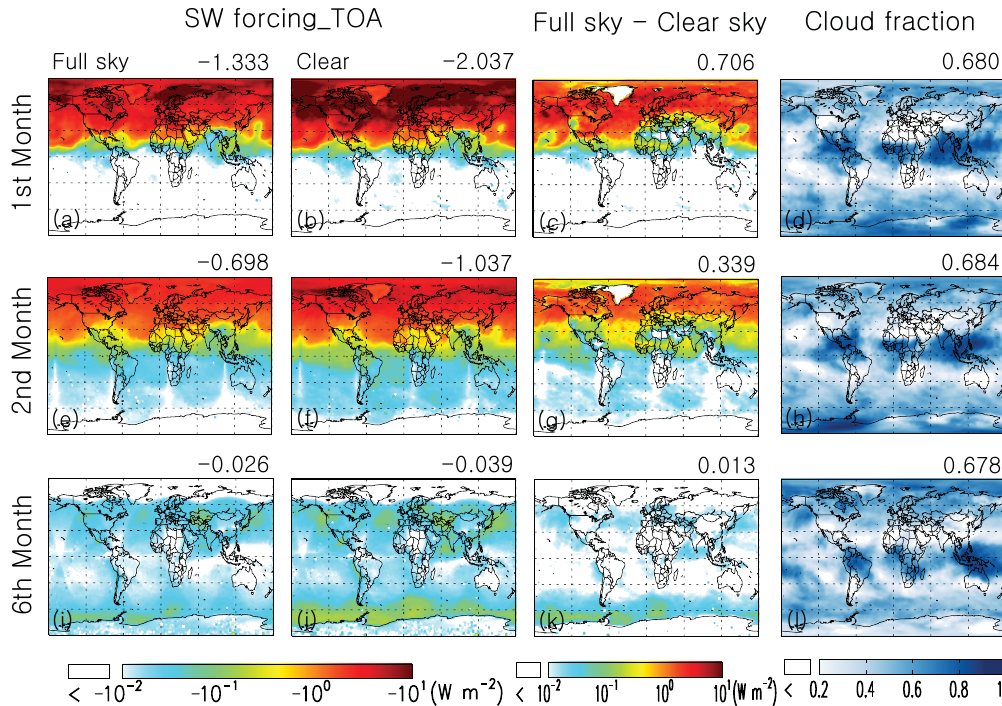
Fig. 8. Averages of volcanic sulfate shortwave (SW) radiative forcing (Wm − 2 ) at the top of the atmosphere (TOA) for all sky (a) and clear sky (b) conditions, as well as their differences (c) in the first month ( a–c ), second month (e–g) , and the 6th month (i–k) after the Kasatochi eruption on 8 August 2008. Also shown are the corresponding distributions of cloud fraction ( d , h and l ). Denoted on the top right of each panel is the global average (weighted by gridbox area) of the corresponding quantity.